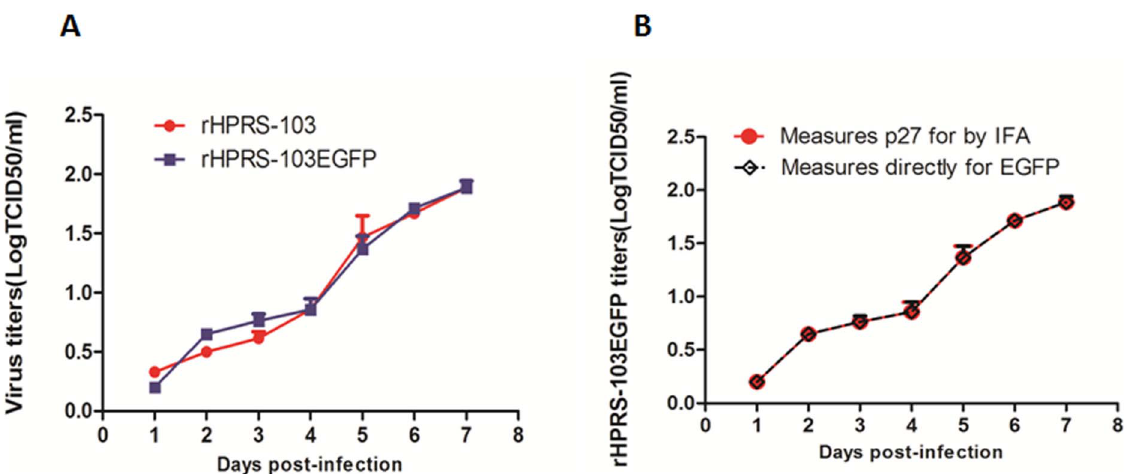
Fig. 2. Replication of rHPRS-103EGFP and rHPRS-103. A, Growth kinetics assay of rHPRS-103EGFP and rHPRS-103. B, The growth kinetics of rHPRS- 103EGFP was measured by p27 expression using IFA while the fluorescence is a direct measure of EGFP-positive